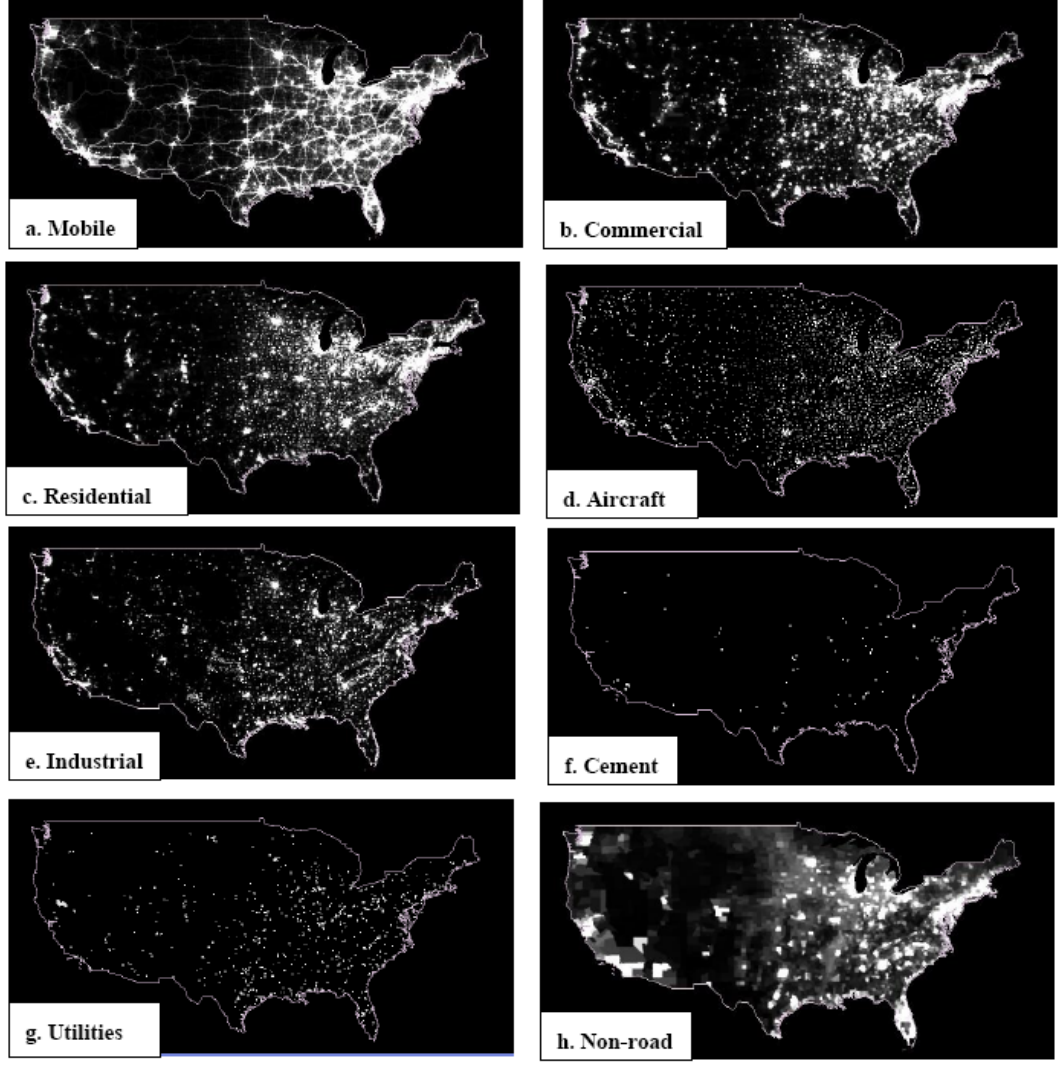
Figure 3. Vulcan sectoral carbon emissions data, 2002. Note that a contrast enhancement was applied to each image to reveal the spatial